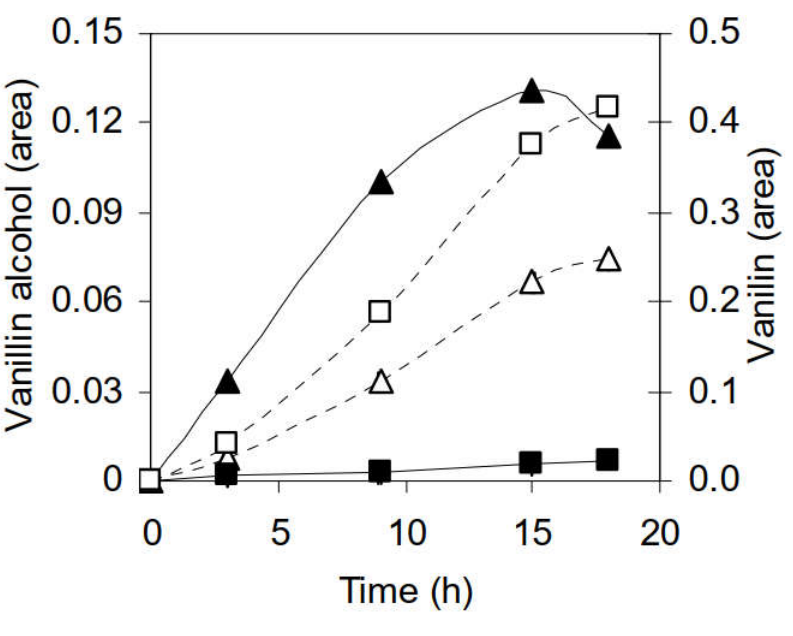
Figure 3. Phenolic compounds found in fed-batch cultivation with spruce hydrolysate. Numbers represent the percentage ratio at the end of fed-batch cultivation between the amount of compound measured and the amount of compound added to the medium. Values above 100 indicate that the compound was produced during the cultivation while values below 100 indicate compound con- version. The amount of each phenolic compound added during the fed-batch cultivation was calcu- lated based on the initial concentration of the compound in the spruce hydrolysate.